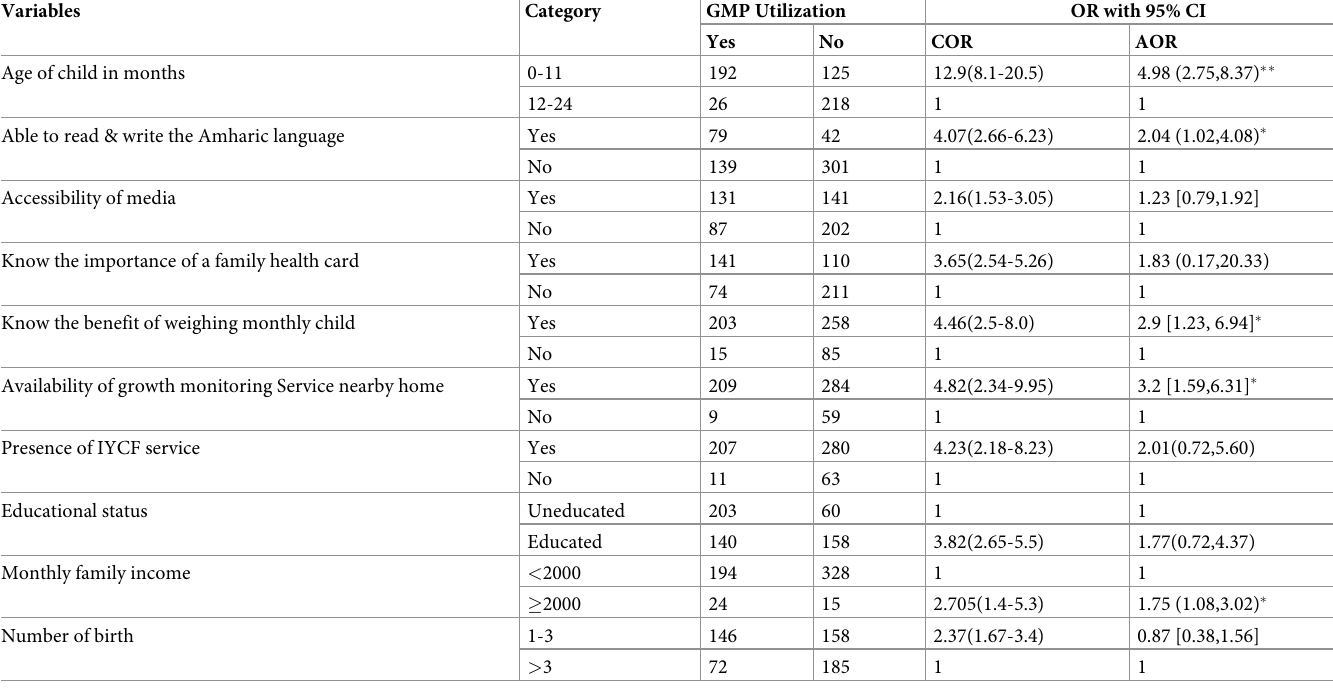
Table 7. Binary and multivariable logistic regression analysis for factors of GMP services utilization among children 0–23 months in Banja District, Northwest Ethiopia, 2020 (n =